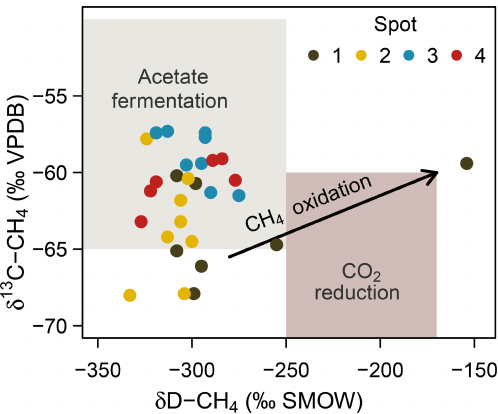
Figure 8. Projection of the CH 4 stable isotope composition to dif- ferentiate dominating methanogenic pathways and methanotrophy. Isotope thresholds to confine methanogenic pathways are based on Whiticar et al. (1986). The concurrent increase in δ 13 C-CH 4 and δ D-CH 4 values at spot 1 suggests a downward shift towards increas- ing CO 2 reduction or CH 4 oxidation rates at